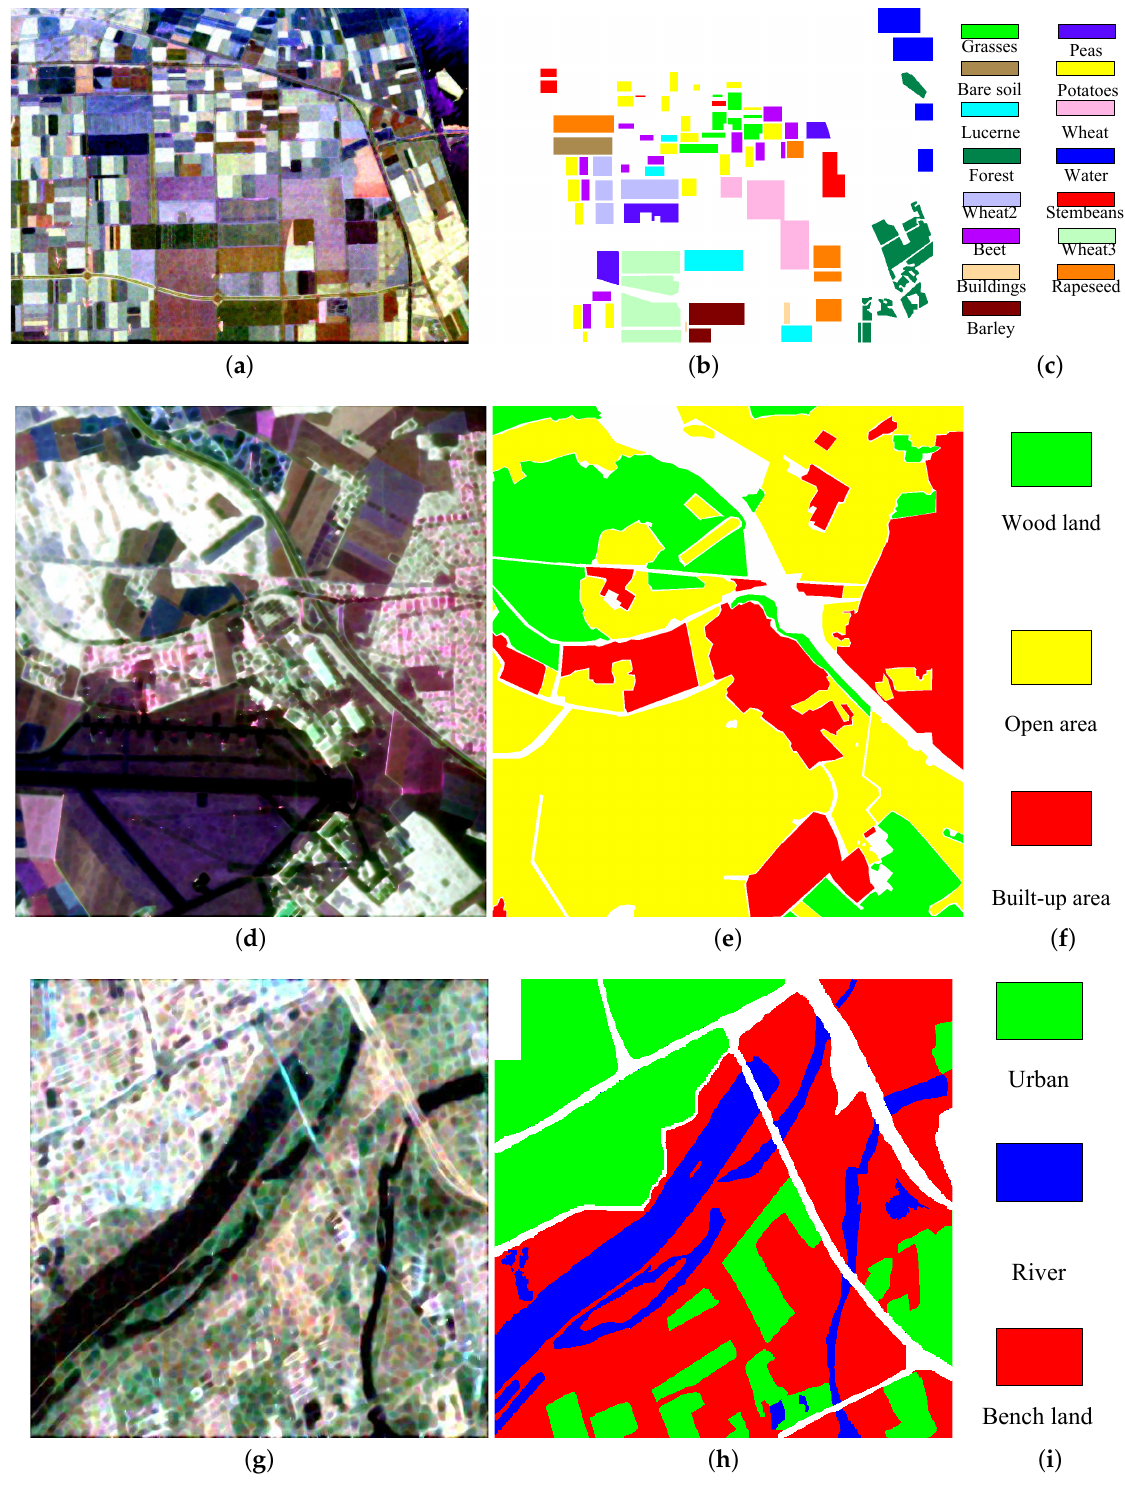
Figure 2. Three fully polarimetric images. ( a ) PauliRGB image of Flevoland, ( b ) ground-truth map with ( c ) legend; ( d ) PauliRGB image of Oberpfaffenhofen, ( e ) ground-truth map with ( f ) legend; and ( g ) PauliRGB image of Xi’an area, ( h ) ground-truth map with ( i )